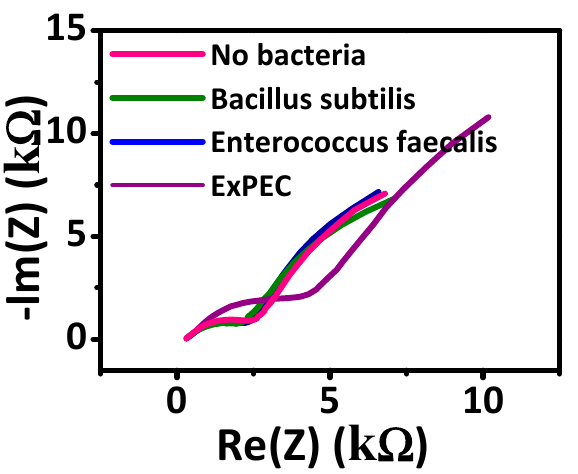
Figure 7. EIS study for E. faecalis (4.0×10 3 CFU mL − 1 ), B. subtilis (4.0×10 3 CFU mL − 1 ), and ExPEC (4.0×10 3 CFU mL − 1 ).